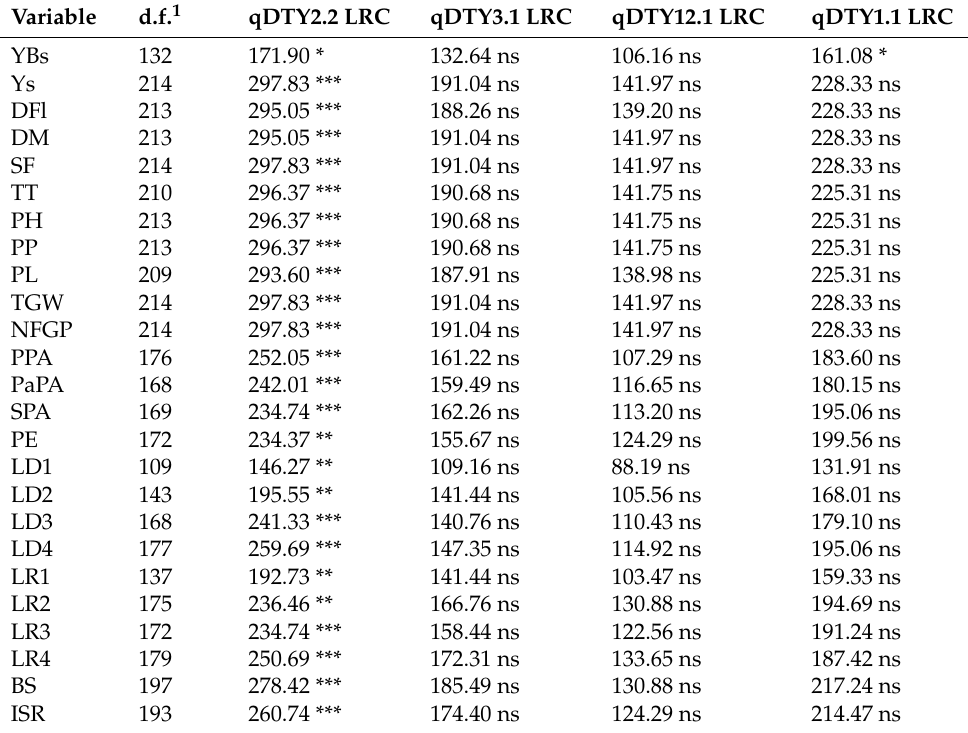
Table 4. Chi-Square test of independence for phenotypic and genotypic data.